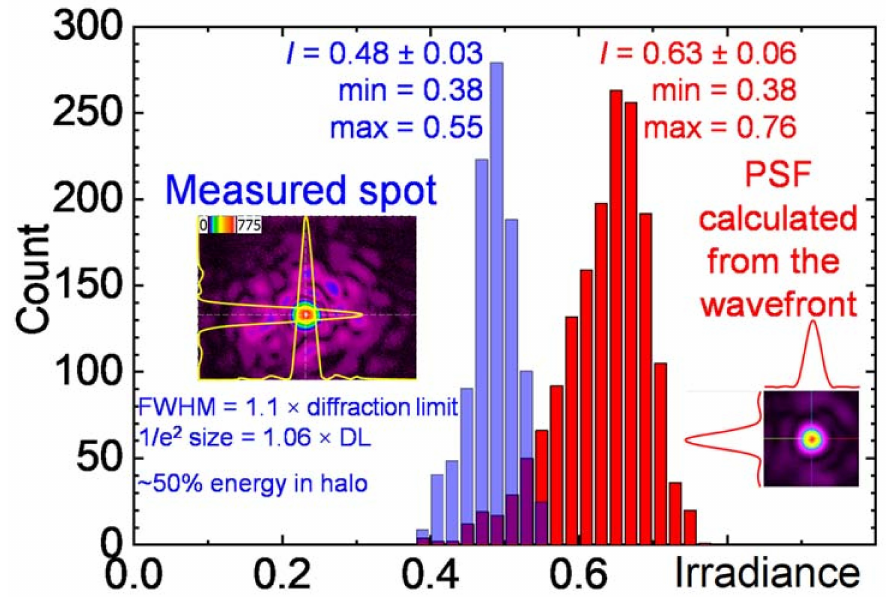
Figure 8. Normalized irradiance distributions obtained from the direct spot measurement (blue) and from Point-Spread Function (PSF) calculated from the measured wavefront (red). Examples of the measured spot and the calculated PSF are shown in the left and right insets, respectively. DL: diffraction